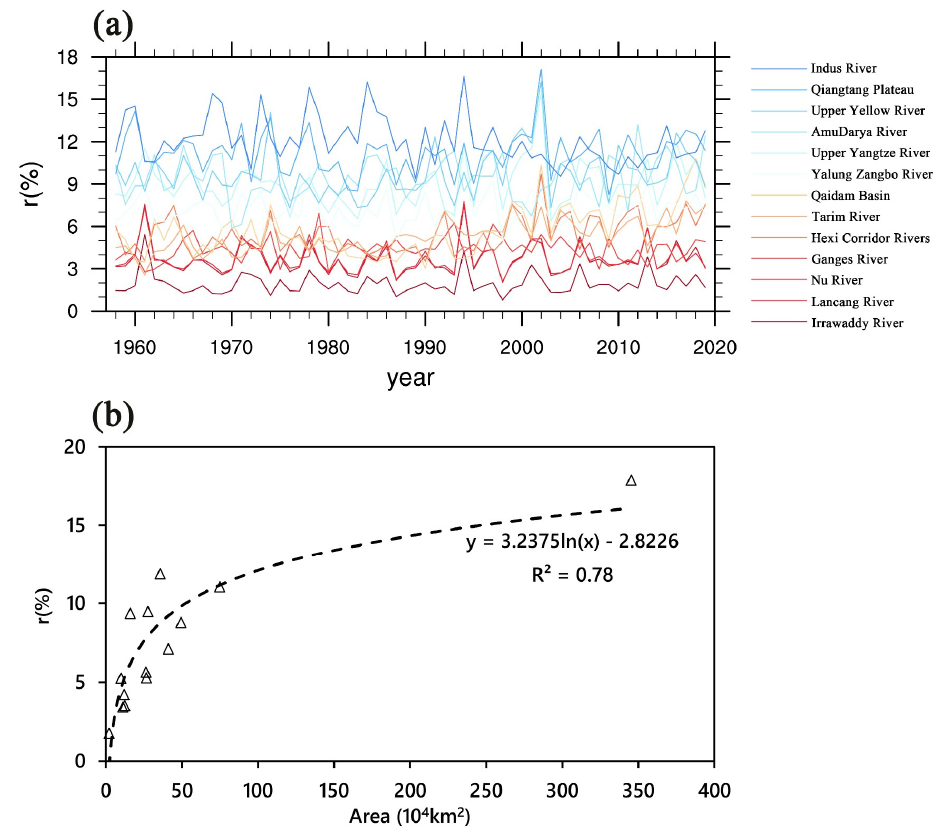
Figure 8. ( a ) Time series of PRRs in different basins of the TP. ( b ) The relationship the PRRs and the basin areas of the TP and its basins.